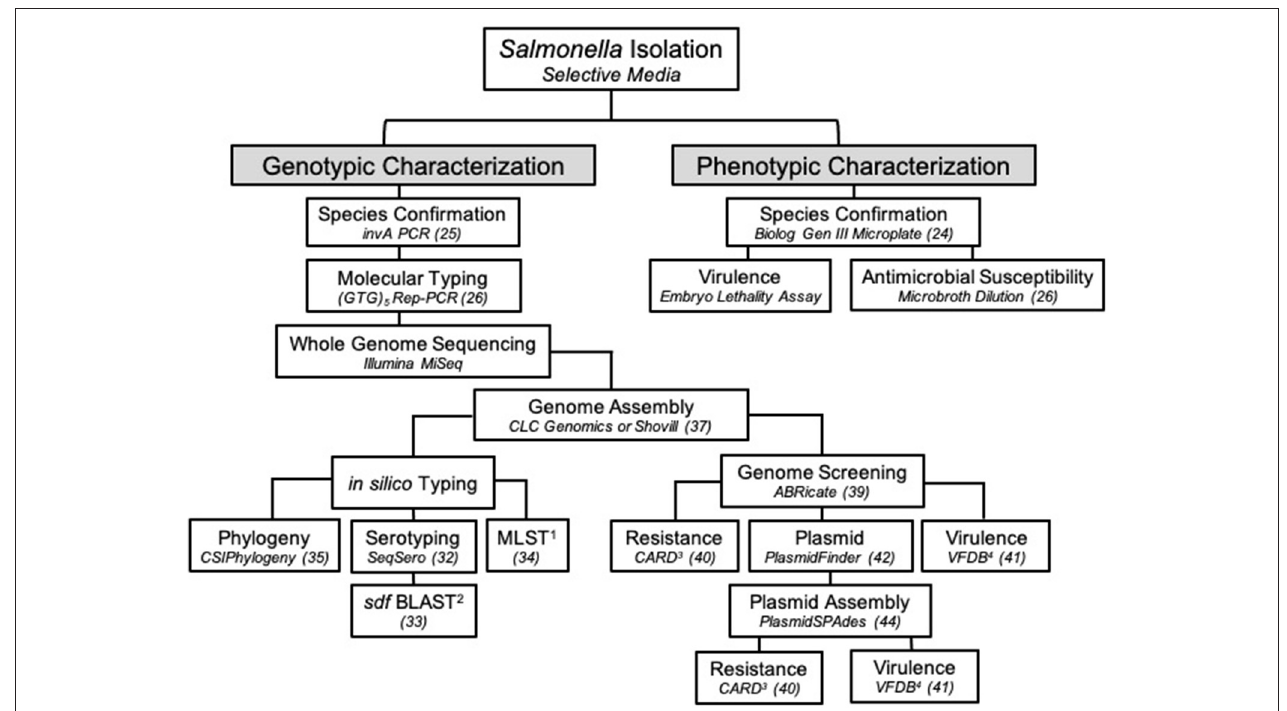
FIGURE 3 | The workflow used to characterize Salmonella Enteritidis strain SE_TAU19 isolated from broiler chickens in this study. Specific methods or software and/or the corresponding reference are indicated in italics for each step. 1 MLST, multilocus sequence typing; 2 BLAST, basic local alignment search tool; 3 CARD, comprehensive antibiotic resistance database; 4 VFDB, virulence factor